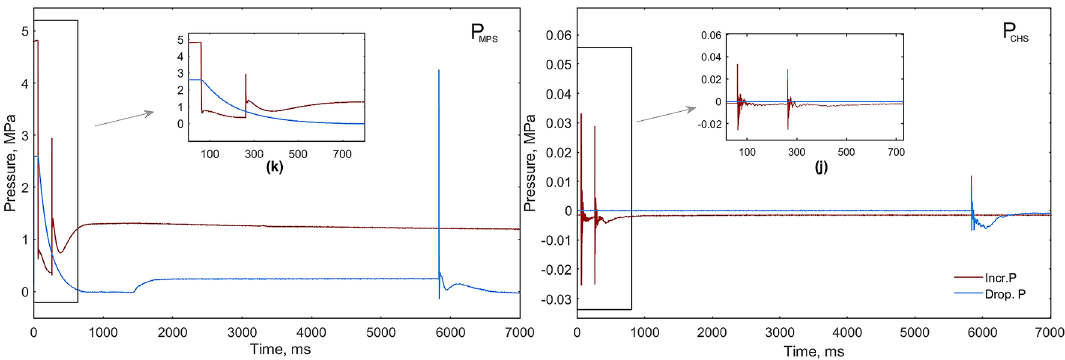
Fig. 7 Pressure variation in the MPS (P by increasing (Incr. P line) and decreasing the pressure (Drop. P line)in the